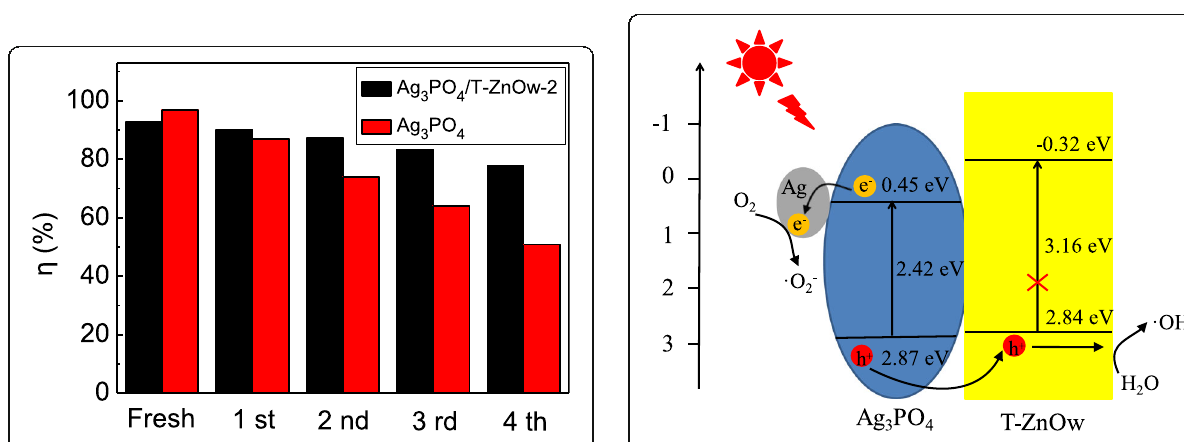
Scheme 1 Schematic diagram of the possible photocatalytic mechanism of Ag 3 PO 4